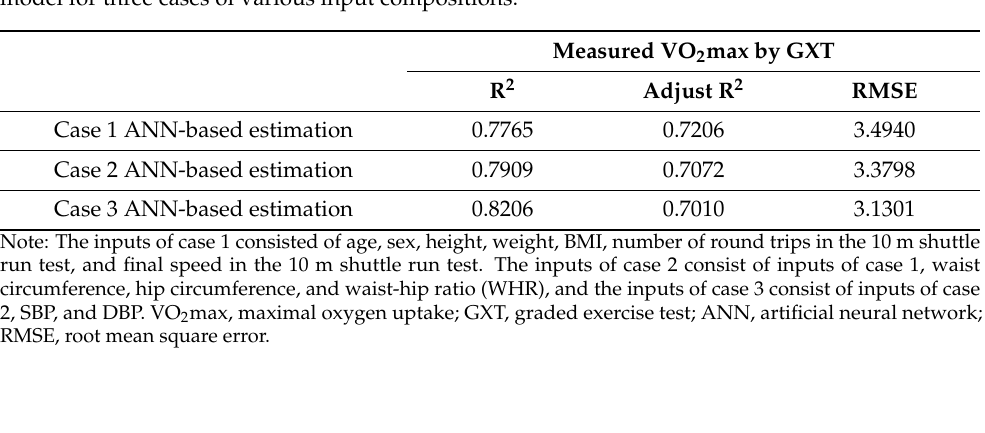
Table 4. Estimation accuracy of artificial neural network-based maximal oxygen uptake estimation model for three cases of various input